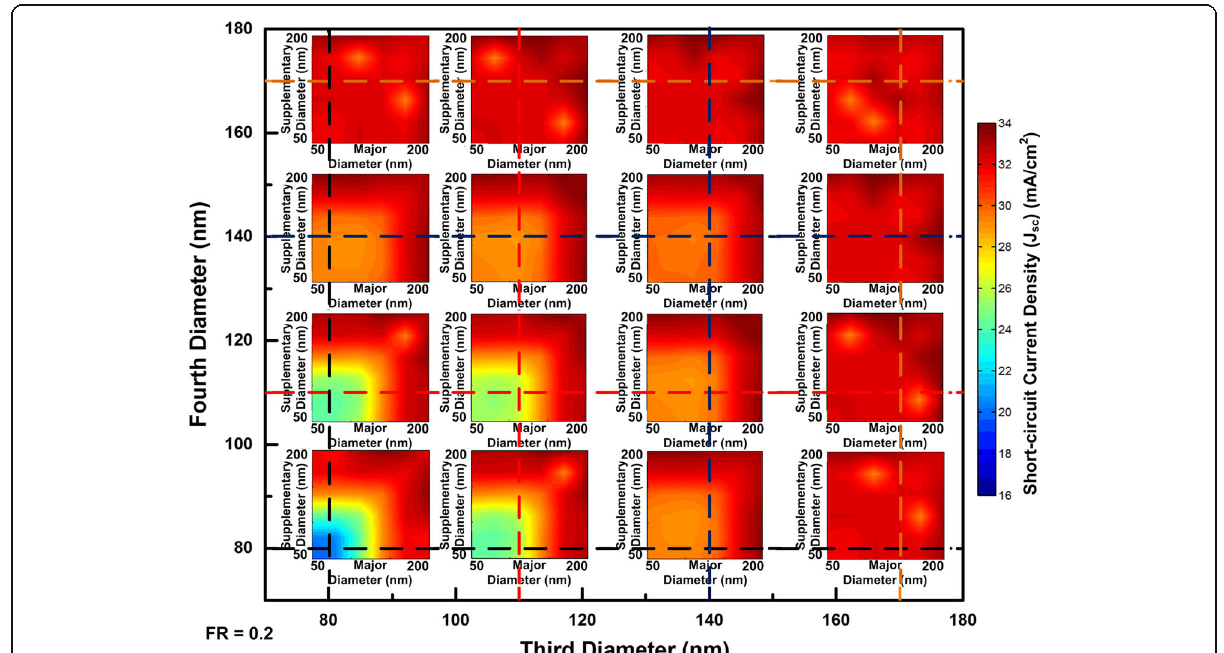
Fig. 9 Short-circuit current densities change with the major, supplementary, third, and fourth InP